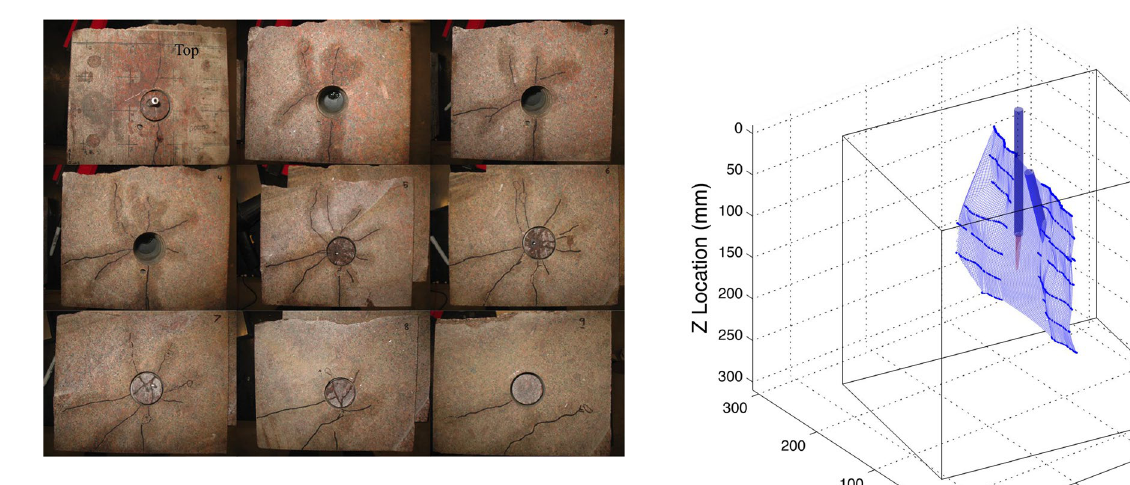
Fig. 10 Slabbed sample photos showing complex network of hydrau- lic fractures stenciled for clearer view; depth increases from top left to bottom right